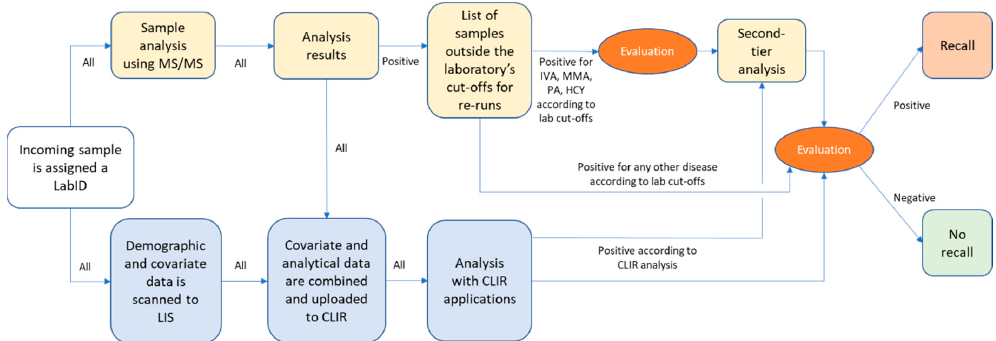
Figure 1. Flow ‐ chart of the present work ‐ flow for MS/MS screening in the Swedish newborn screening Figure 1. Flow-chart of the present work-flow for MS / MS screening in the Swedish newborn